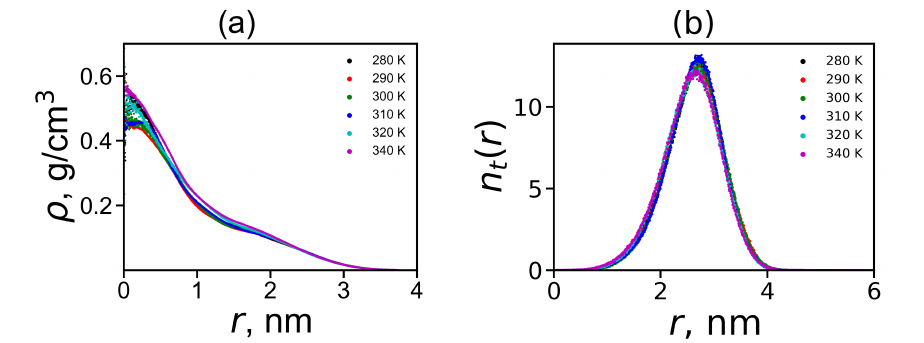
Figure 4. The radial density distribution function of the Lys-2Arg dendrimer atoms ( a ) and the radial distribution function of the number of terminal atoms ( b ) at different temperatures. Both functions are counted from the center of mass of the